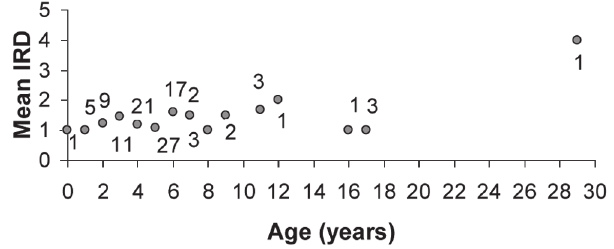
Fig. 5. Observed mean inter-read discrepancy (IRD). Age is the first reading (number of rings) of the dog snapper Lutjanus jocu from Abrolhos Bank. The numbers represent the sample size.